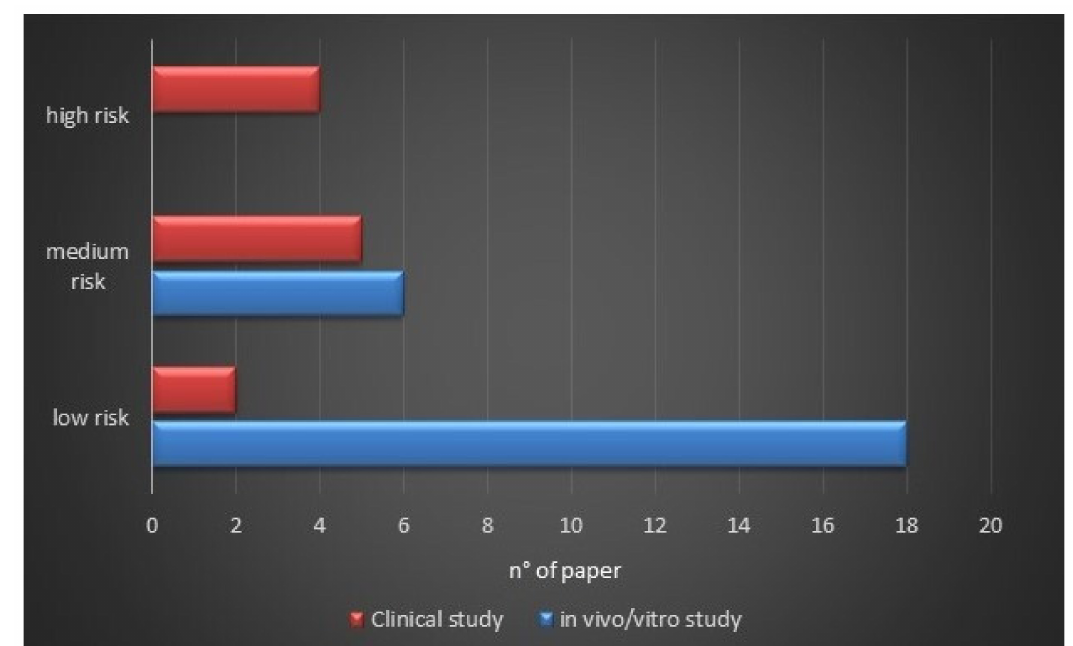
Figure 6. The quality assessment is based on a checklist adapted from the Cochrane Handbook for Systematic Reviews of Interventions. The pre-clinical (indicated by blue bar) and clinical studies (indicated by red bar) have been classified in high, medium, and low risk of